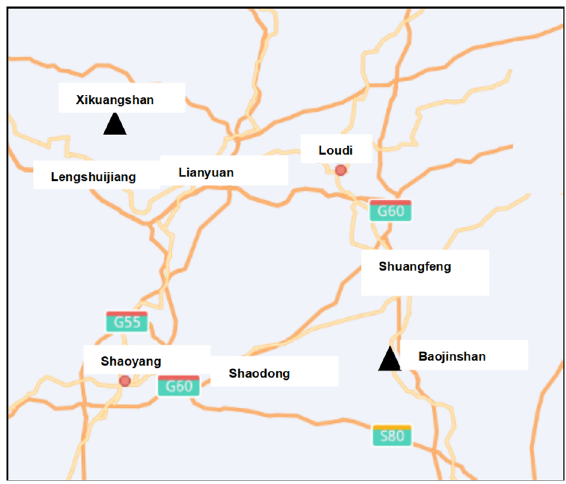
Figure 1. Location map of the study area. Table 2. Element content table of Xikuangshan ore leachate.